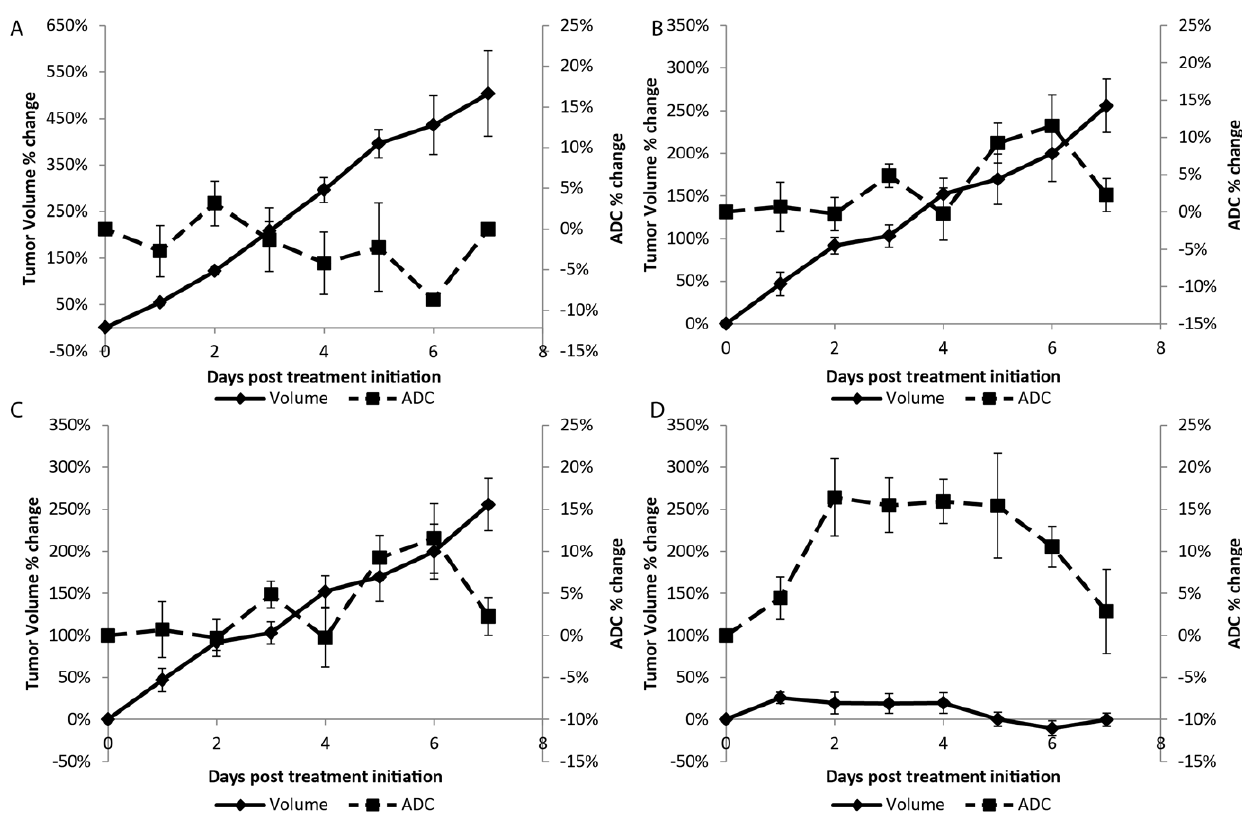
Figure 2. Plots of the percent change in tumor volume and normalized ADC (ADC) for each of the treatment groups in Study1 . Presented are treatment groups (A) Control, (B) irradiation (IR), (C) temozolomide (TMZ) and (D) combination temozolomide and irradiation (TMZ + IR). Data is presented over the first week of the study as the mean 6 SEM.